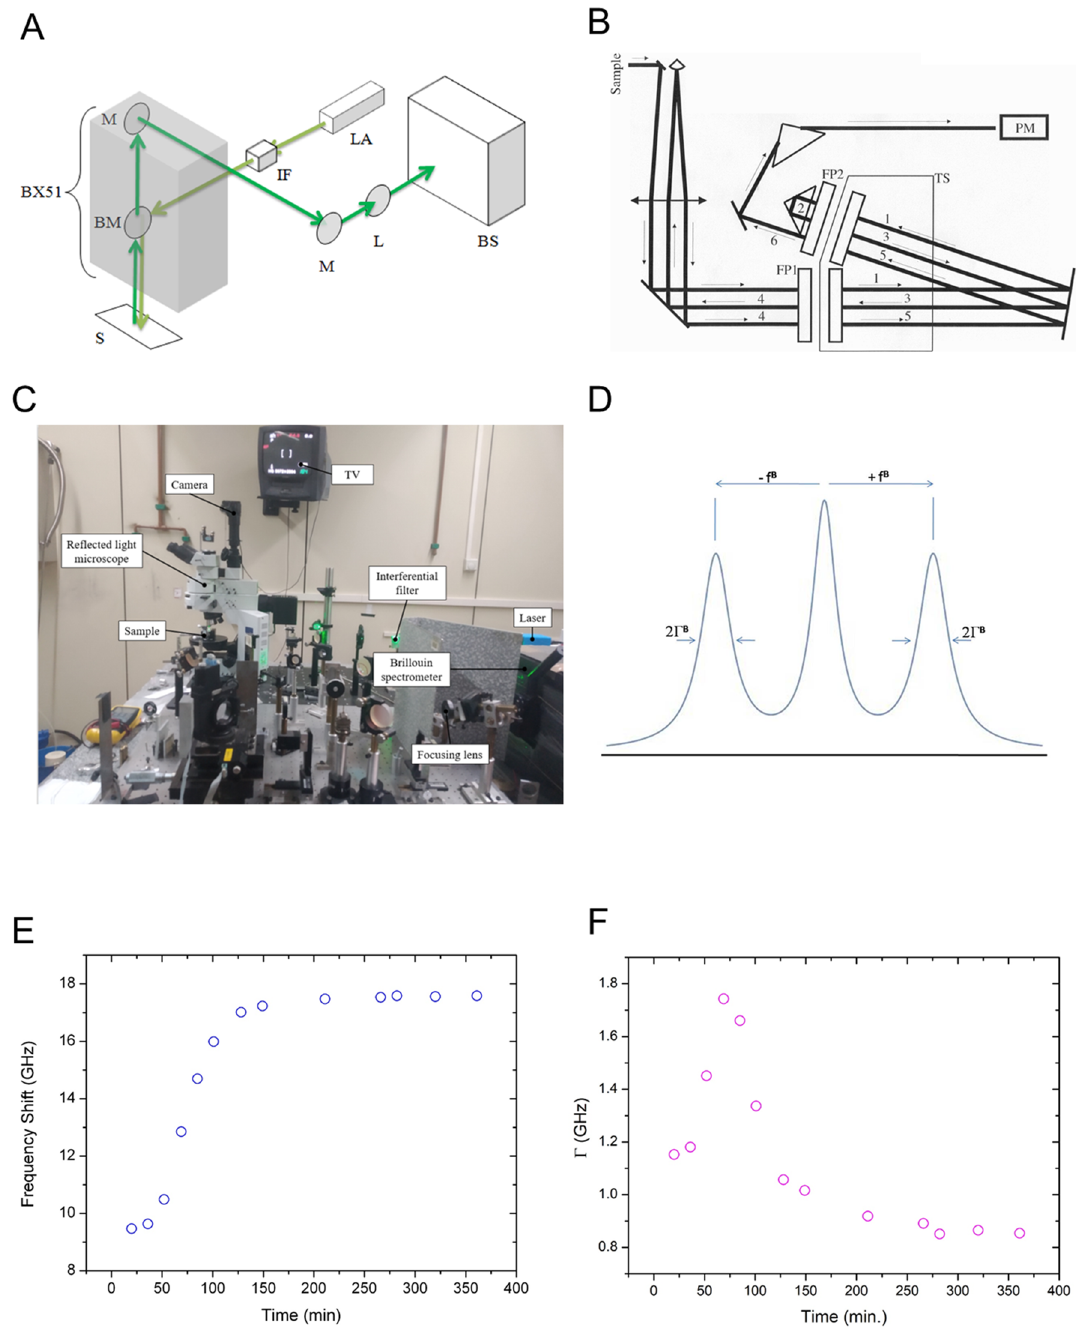
Figure 1. Schematics of the Brillouin spectroscopy setup and experimental arrangement. ( A – C ) Experimental set up used to perform Brillouin microspectroscopy (mBS) measurements combined a home modified Olympus BX51 reflected light microscope with a 3 + 3 Tandem Fabry–Pérot spectrometer. ( A ) Light path schematics of the mBS experiment from laser light source to Brillouin spectrometer passing through the Olympus BX51 microscope. ( B ) Principle of the 3 + 3 Tandem Fabry–Pérot based Brillouin spectrometer. ( C ) Actual picture of the experimental setup. ( D ) Ideal mBS spectrum for a liquid. The Brillouin frequency shift f 180 is defined as f 180 = ω B /2π. ( E , F ) mBS frequency shift (f 180 , E ) and peak width (HWHM, F ) were measured during sample drying for different time